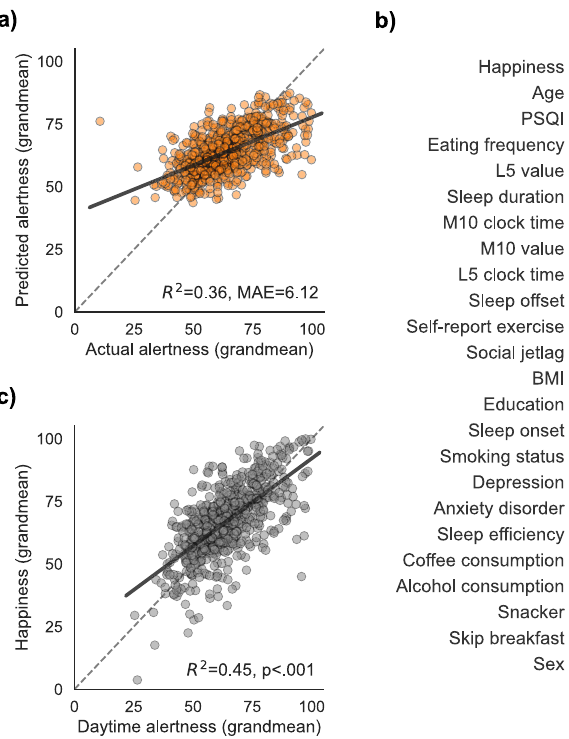
Fig.5|Predictorsoftraitalertness.a Cross-validatedperformanceofthegradient boosting algorithm. Predictions of the trait alertness are plotted against the ground-truth values. Each dot represents an individual ’ s predicted and actual trait alertness. Trait alertness was calculated by averaging, for each individual, all their alertness rating across the two weeks of the study. b Features of the gradient boosting algorithm, ranked by order of descending importance. Features impor- tancewascalculatedusingtheSHAPmethod(see “ Methods ” ).Eachdotontheplot is a Shapley value for a given predictor and participant. Shapley values represent,